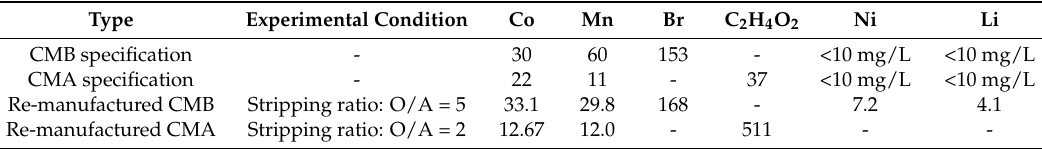
Table 5. Specifications of CMB (Cobalt-Manganese-Bromide) and CMA